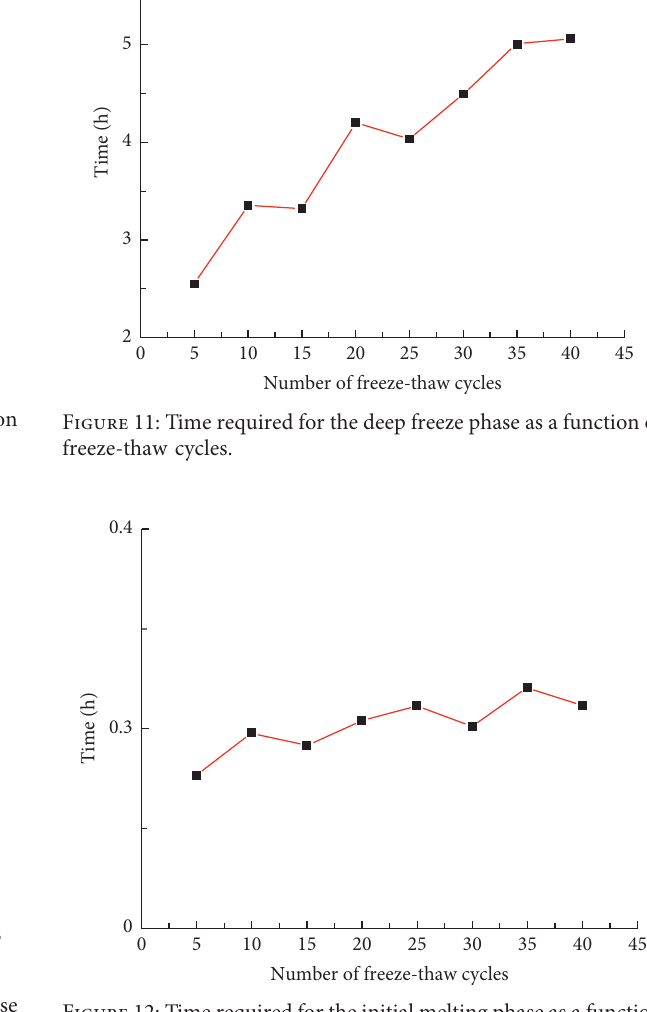
Figure 12: Time required for the initial melting phase as a function of freeze-thaw cycles.